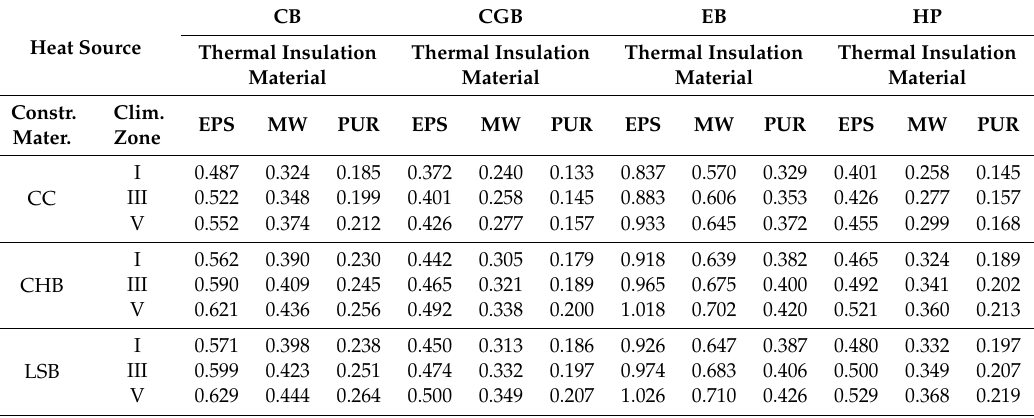
Table 9. Thermal insulation thicknesses d Eopt [m] optimum for ecological